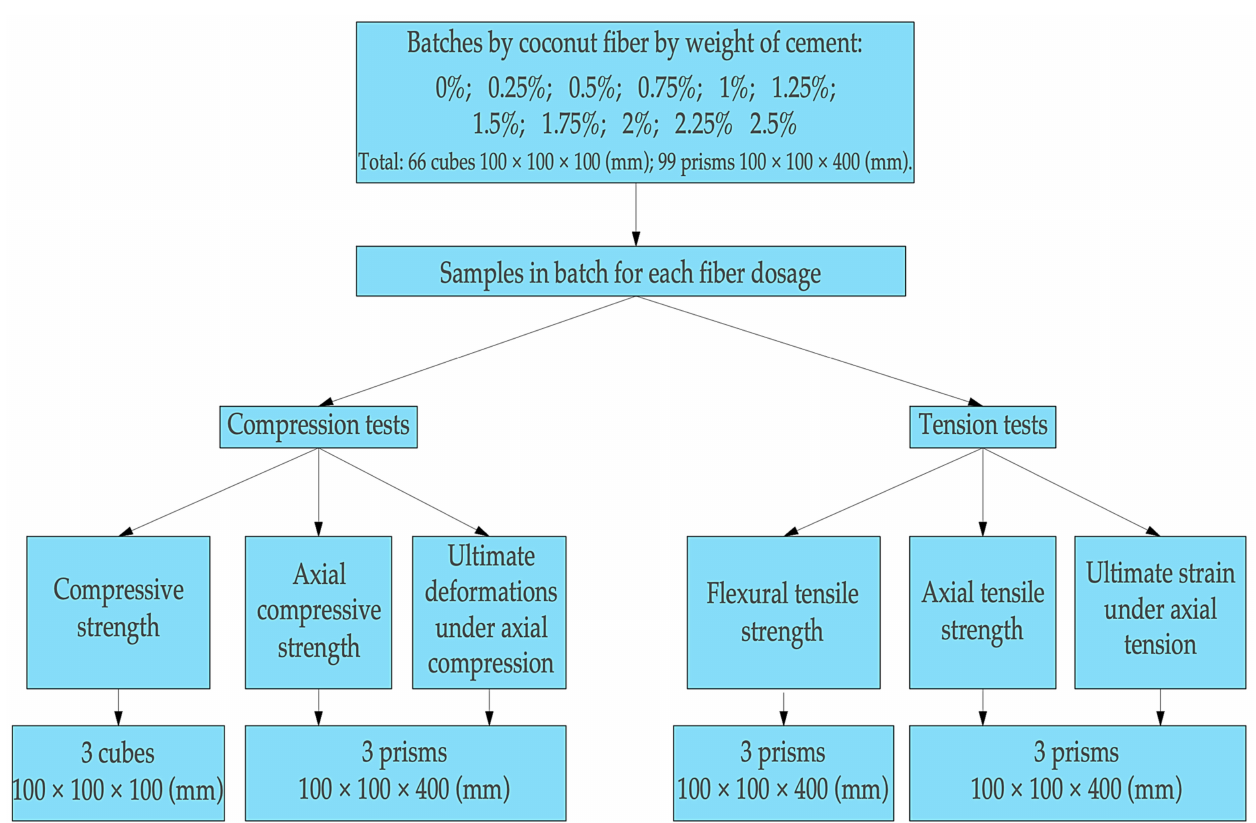
Figure 5. The scheme of the experiment for the effect of dispersed reinforcement with coconut fibers on the strength and deformation properties of concrete.